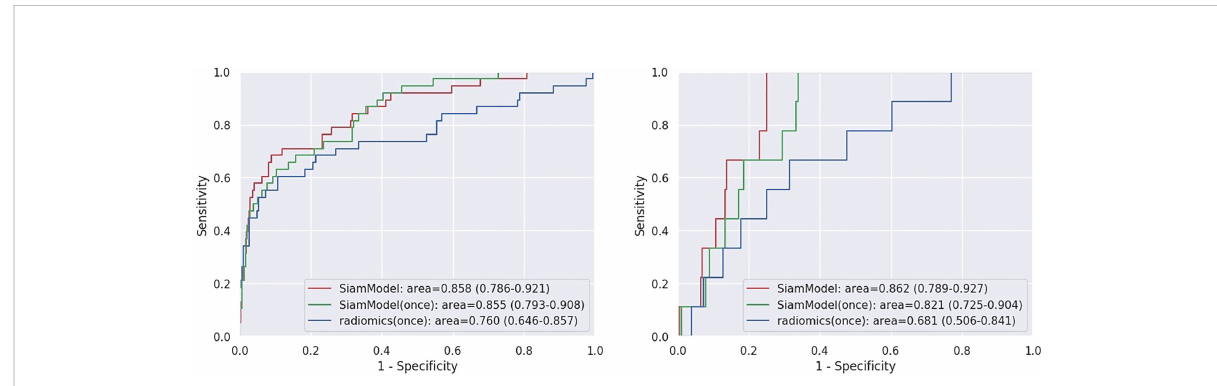
FIGURE 6 Receiver operating characteristic (ROC) curves on NLST validation set (left) and external test set (right). SiamModel (once) and radiomics (once) are only using Tt VOI as